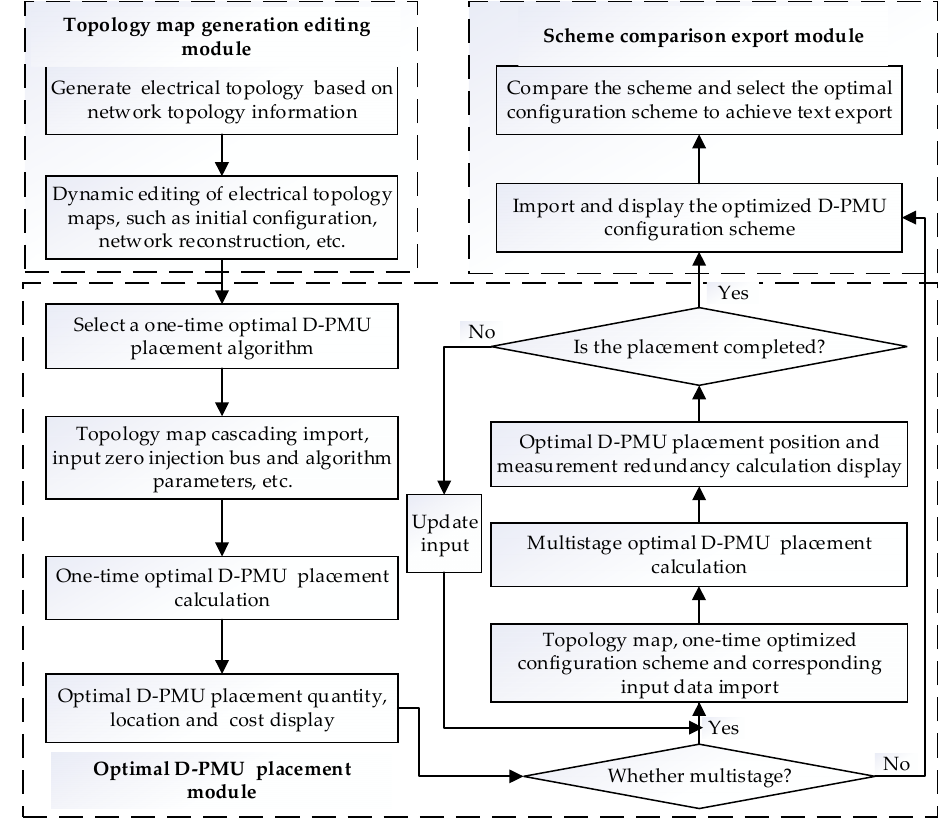
Figure 6. Transaction flow diagram of the software system.